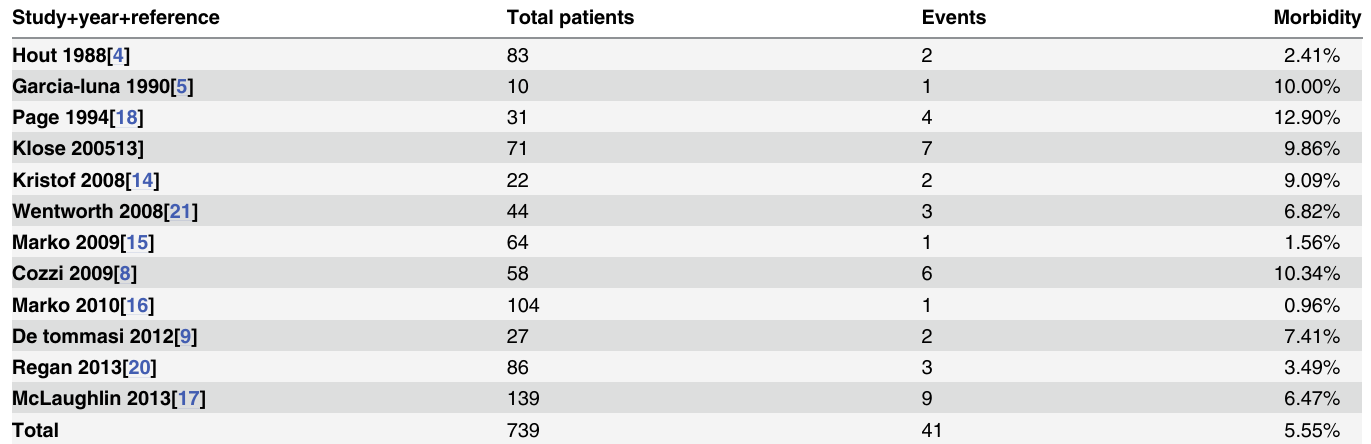
Table 2. The morbidity of postoperative early adrenal insuf fi ciency in patients with normal preoperative MSC